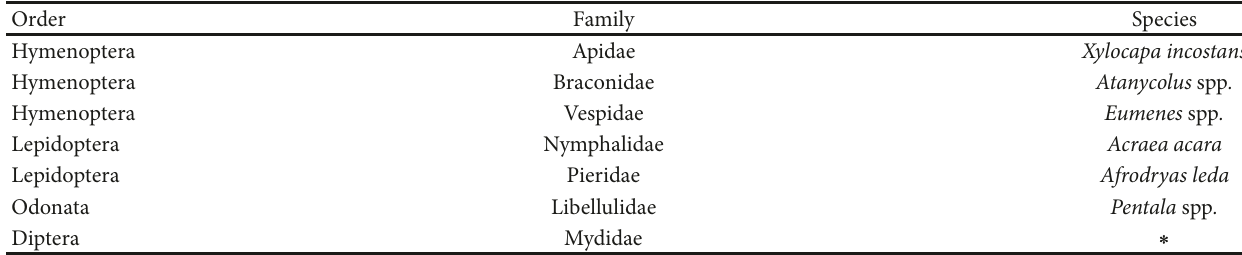
Table 3: Insects observed on Sclerocarya birrea flowers.